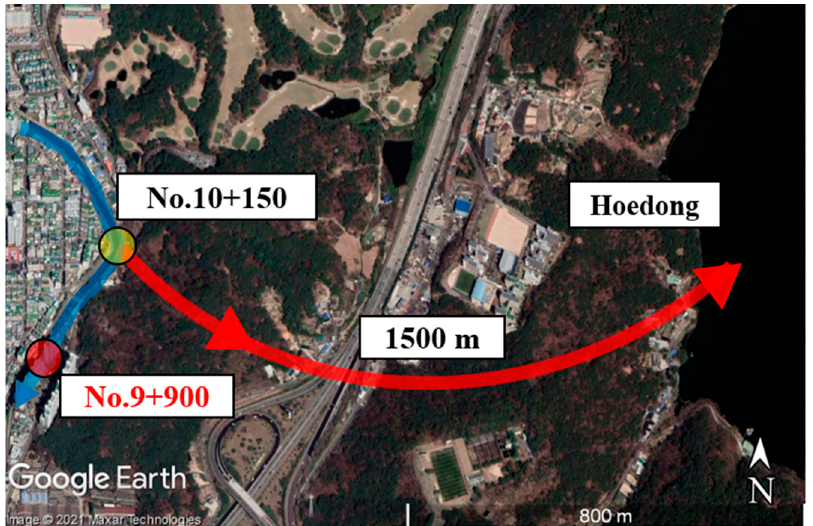
Figure 4. Route map of the underground waterway.